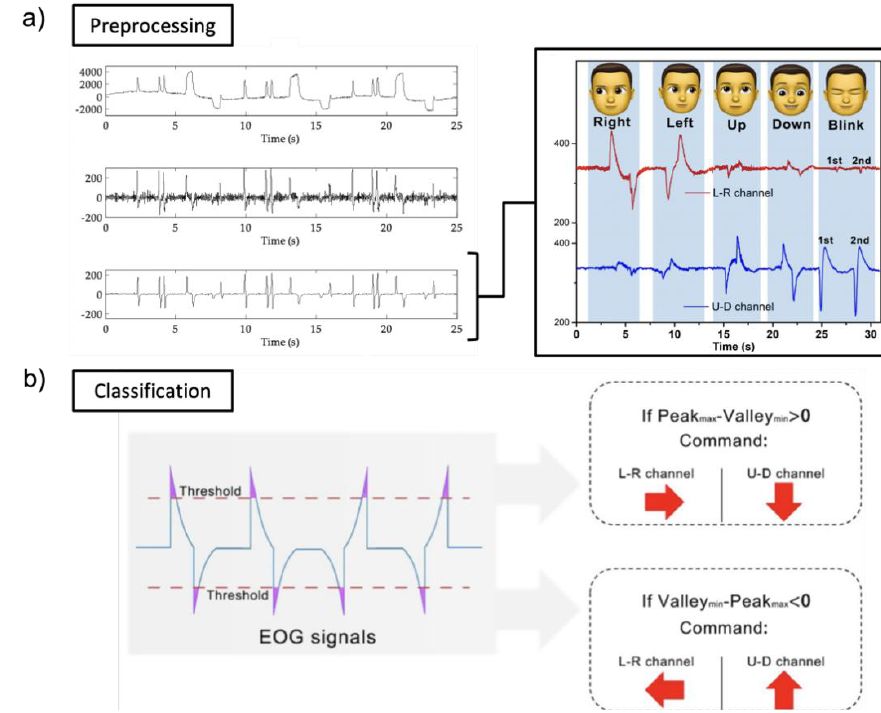
Figure 8. Signal processing and data analysis. ( a ) Recorded EOG signals depending on eye direc- tions (Left: Reproduced under terms of the CC-BY license [51]. Copyright 2017, the Authors. Published by MDPI, Right: Reproduced with permission [61]. Copyright 2021, Wiley-VCH GmbH). ( b ) Schematic algorithm diagram using threshold (Reproduced with permission [61]. Copyright 2021, Wiley-VCH GmbH).